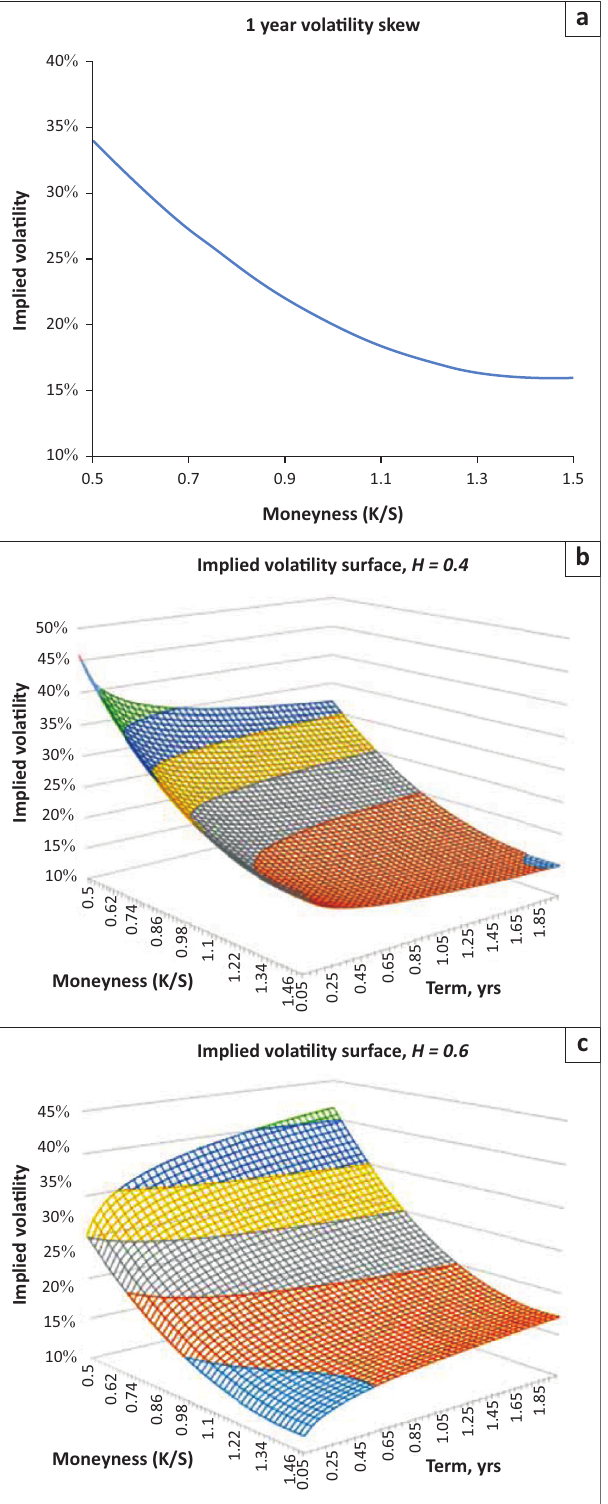
FIGURE 3: Indicative implied volatility surface for fractional volatility and Hurst exponent modelled as a quadratic function of strike.